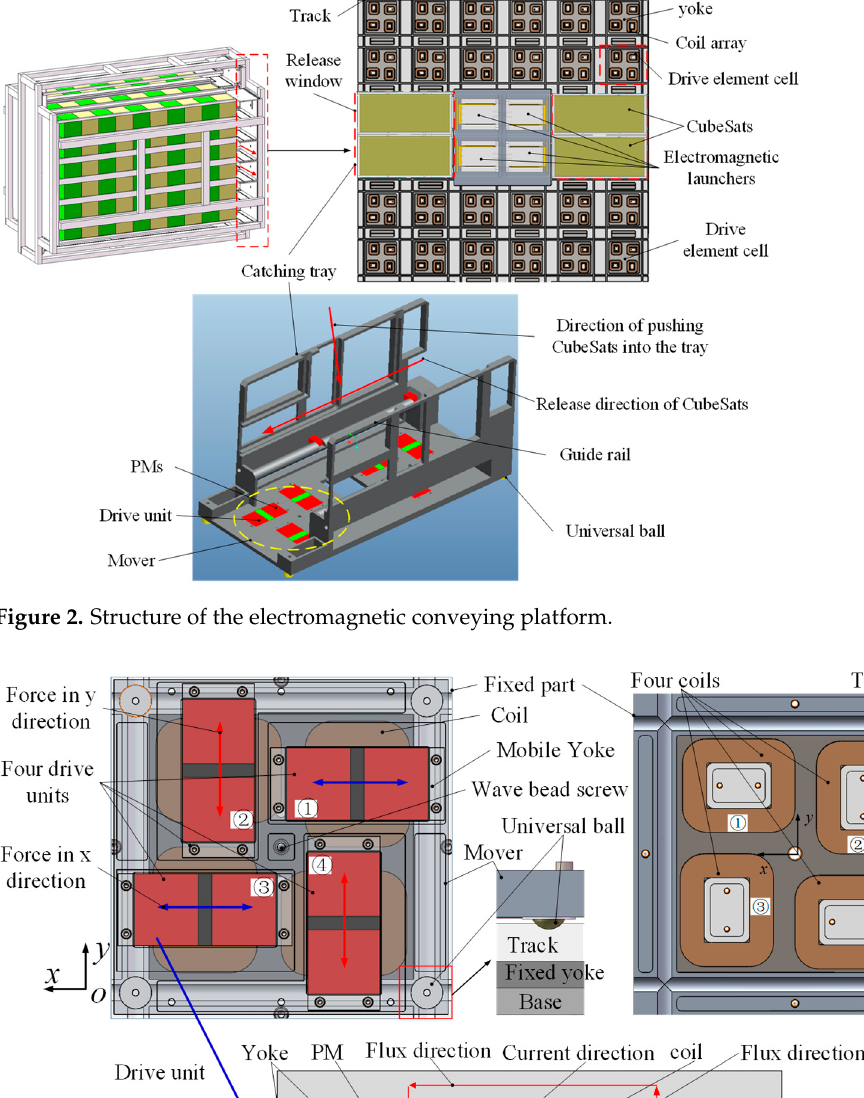
Figure 3. Configuration of the drive element cell and the mover.